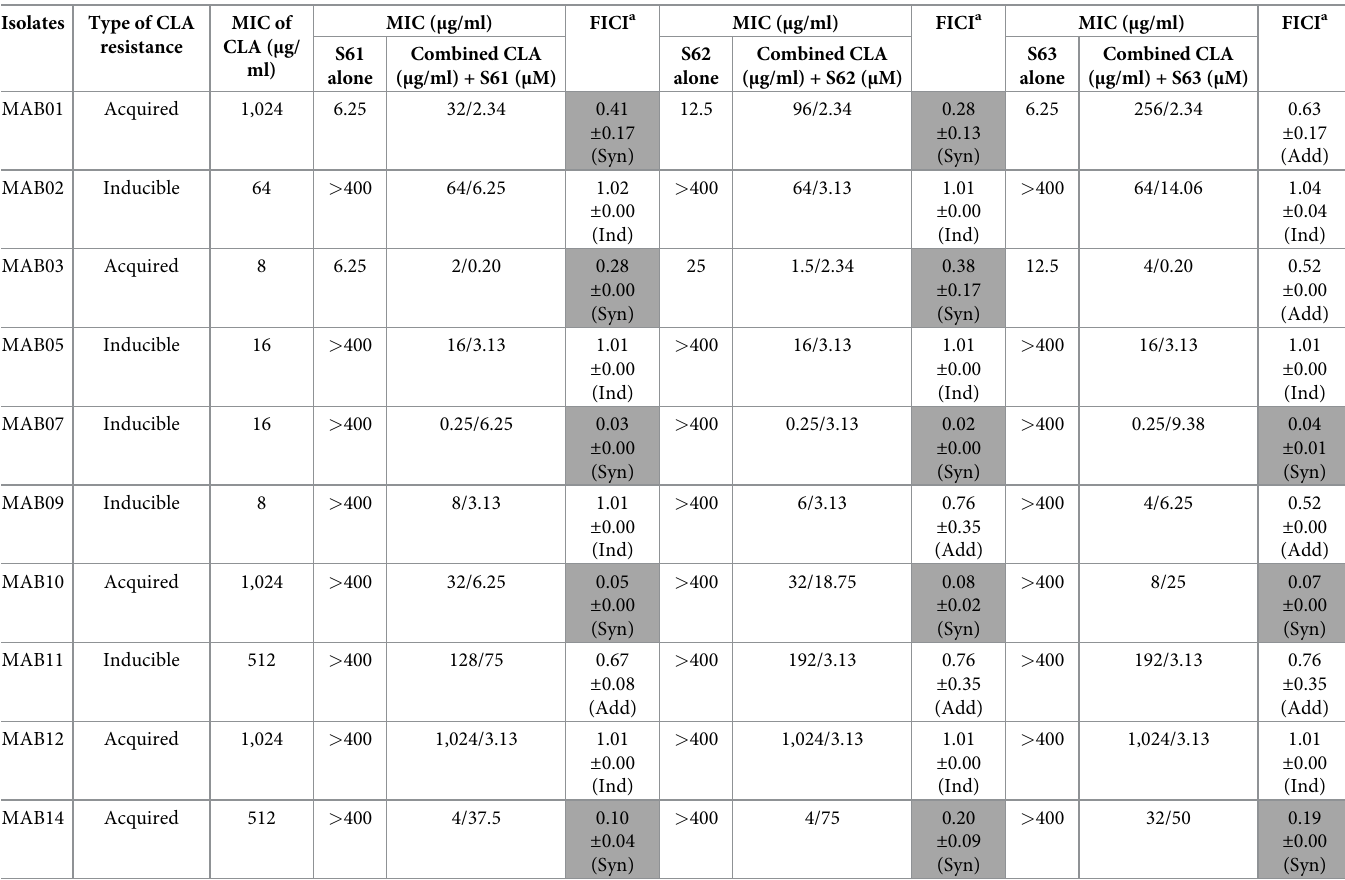
Table 3. In vitro interaction effects between AMPs (S61, S62, S63) and clarithromycin against M . abscessus clinical isolates. Isolates Type of CLA